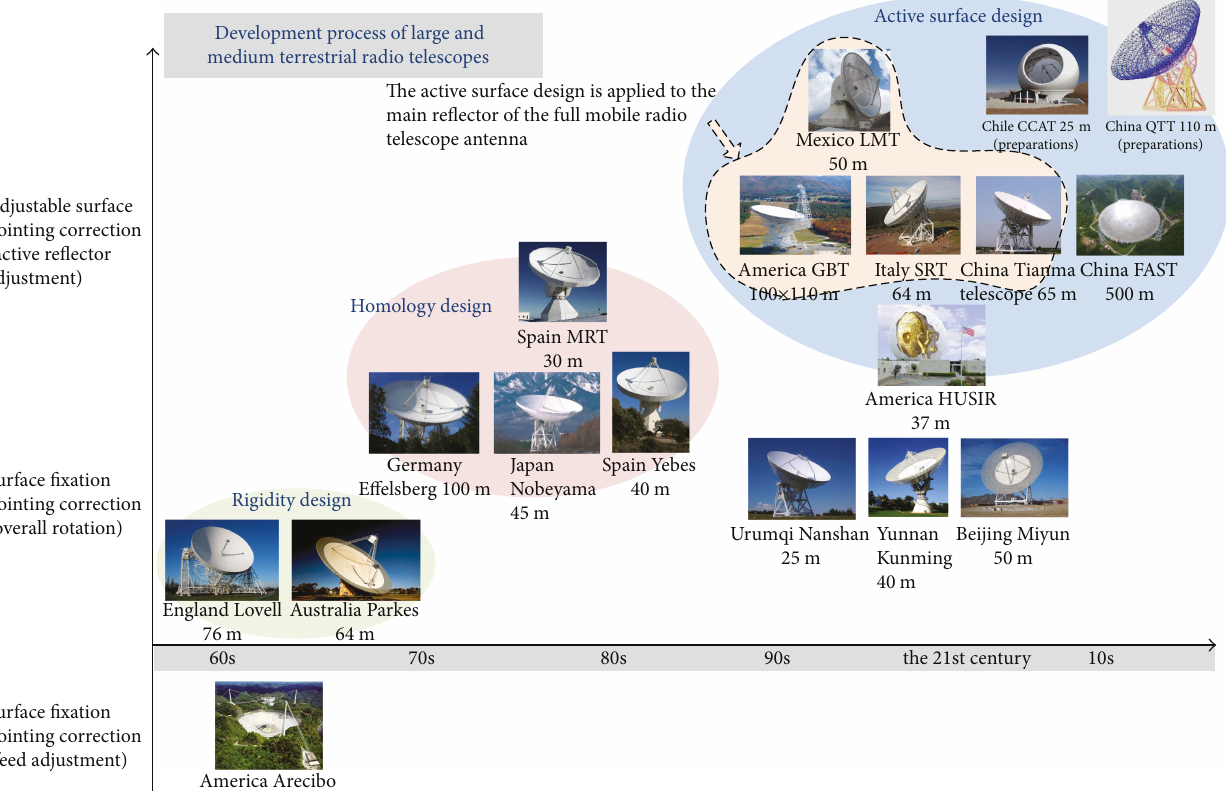
Figure 1: Development history of radio